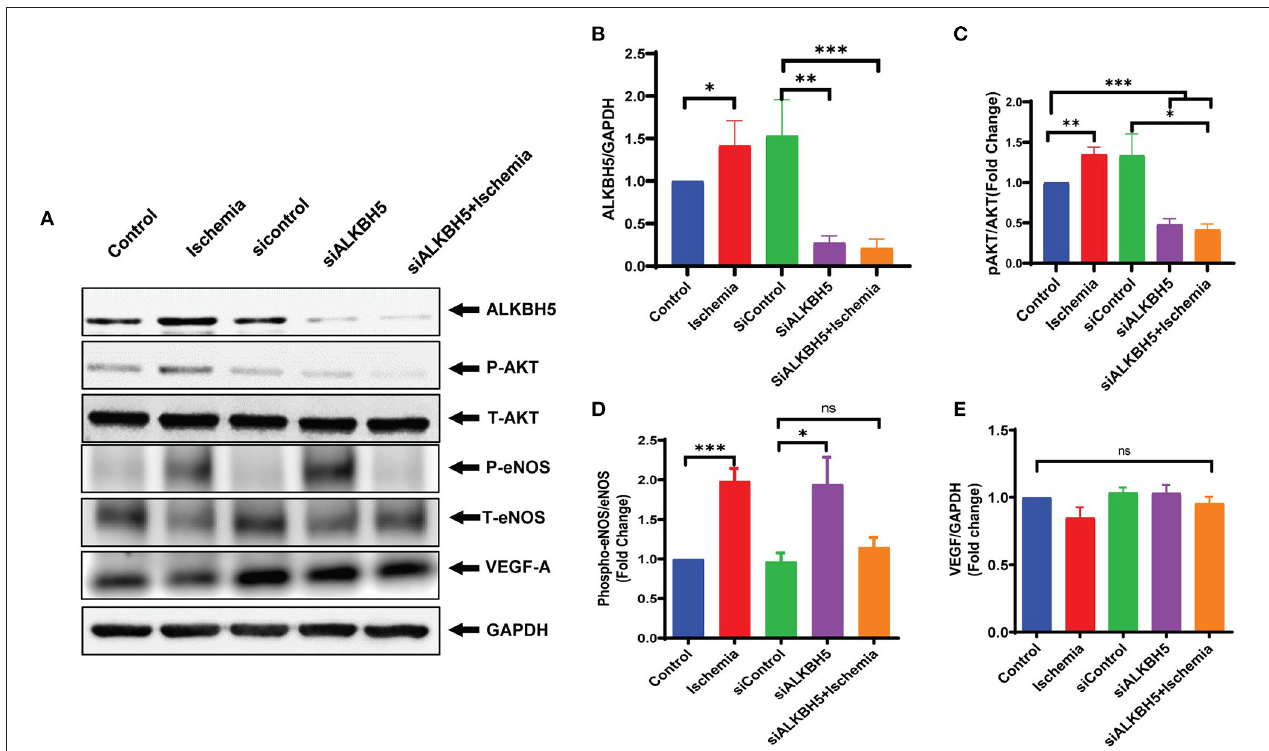
FIGURE 4 | Measurement of endothelial angiogenesis markers following ischemic stimulation. HMVE cells were cultured under ischemia for 24 h. (A) Western blot showing expression of ALKBH5, Phospho AKT, Total AKT, phospho-eNOS, total eNOS and VEGF-A. (B) Quantification of ALKBH5 vs GAPDH. (C) Quantification for Phospho-Akt vs Total-AKT level. (D) Quantification of Phospho-eNOS vs Total-eNOS. (E) Quantification of VEGF-A vs GAPDH. Ischemic stress after ALKBH5 silencing significantly increased AKT and eNOS phosphorylation but the expression of VEGF-A was not changed. * P < 0.05, ** P < 0.01, *** P < 0.001, ns indicates not significant with respective control ( n =